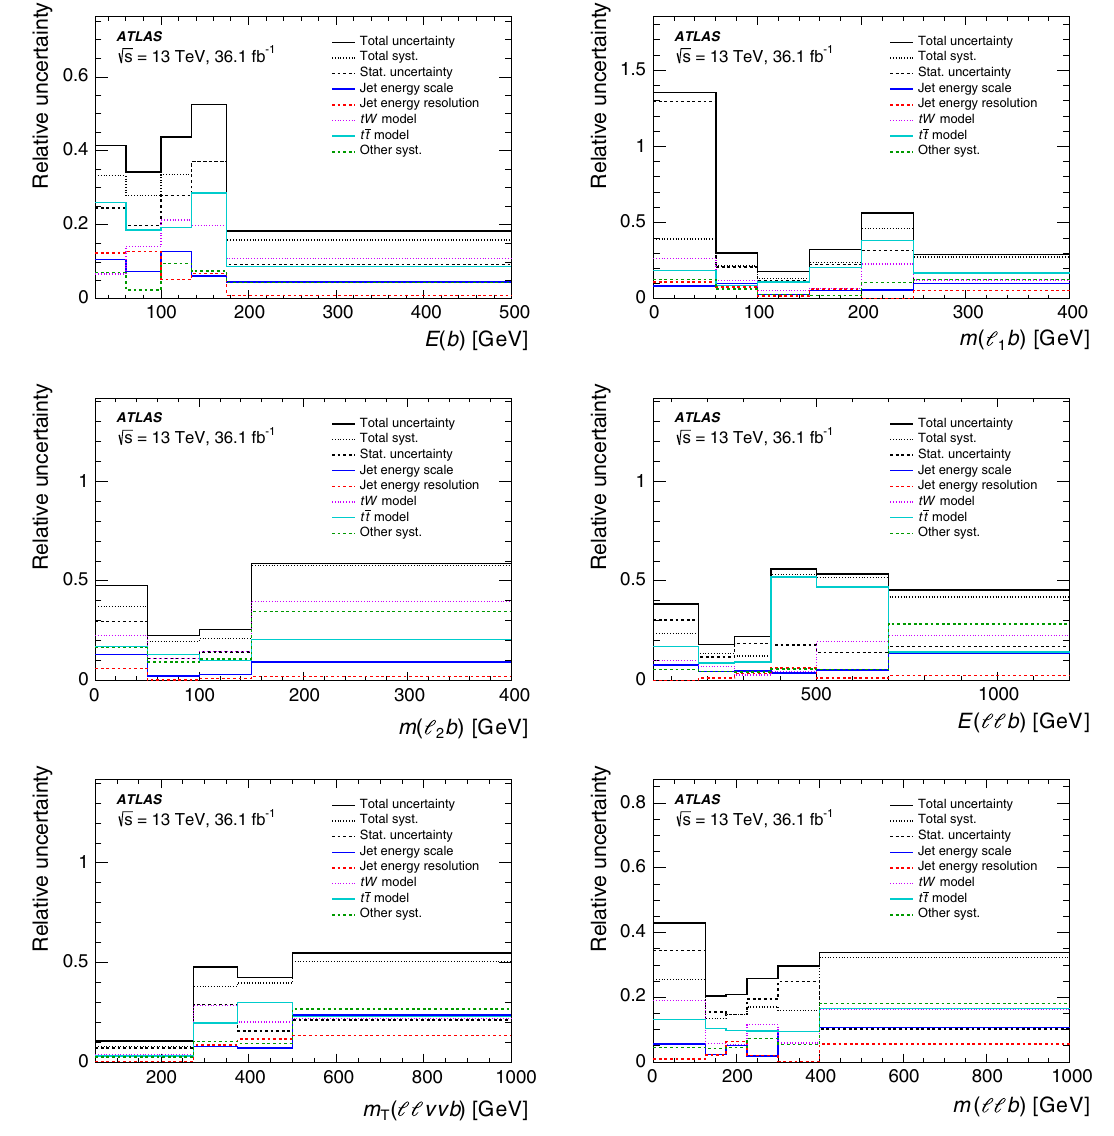
Fig. 7 Summary of uncertainties in normalised differential cross-sections unfolded from data second matrix, the bin-to-bin correlation value is set to zero for the non-closure and MC statistical uncertainties, and set to unity for the other uncertainties. The impact of setting the bin-to-bin correlation value to unity was compared for the non-closure uncertainty, and this choice was found to have negligible impact on the results. This covariance matrix is used to compute a χ 2 and corresponding p value to assess how well the measurements agree with the predictions. The χ 2 values are computed using the expression: χ 2 = v (cid:2) C − 1 v , where v is the vector of differences between the measured cross-sections and